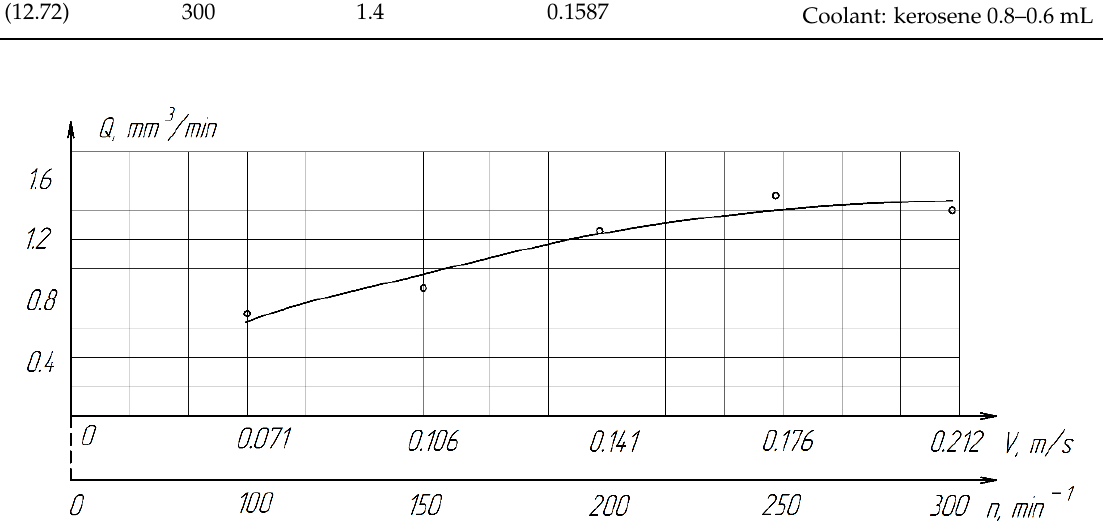
Figure 14. The effect of cutting speed on the processing performance of ZrO 2 ceramics. As the cutting speed increases, the roughness of the treated surface changes slightly from Ra = 0.1739 µ m to Ra = 0.1587 µ m (Figure 15).